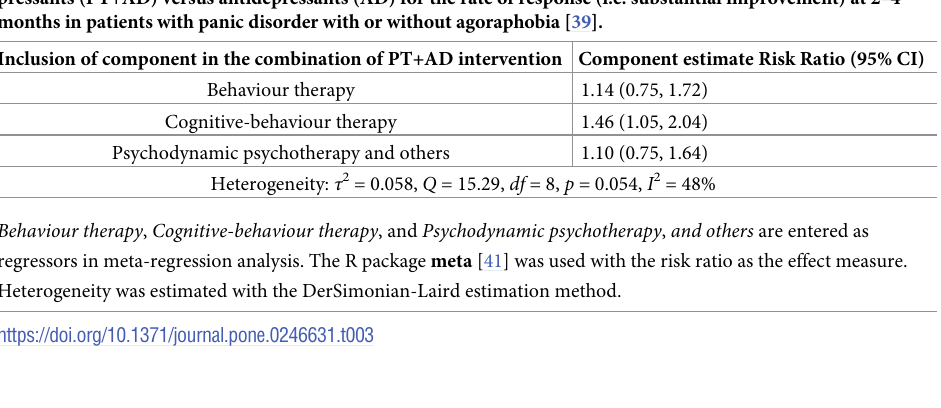
Table 3. Meta-regression results for the synthesis of studies that compared combined psychotherapy plus antide- pressants (PT+AD) versus antidepressants (AD) for the rate of response (i.e. substantial improvement) at 2–4 months in patients with panic disorder with or without agoraphobia [39].